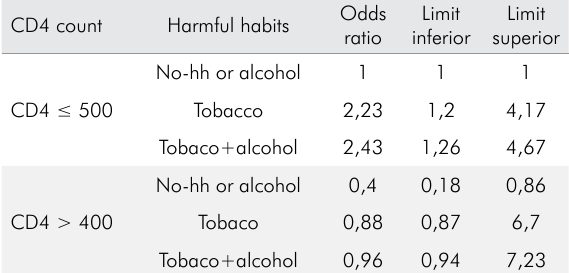
Table. Estimated odds